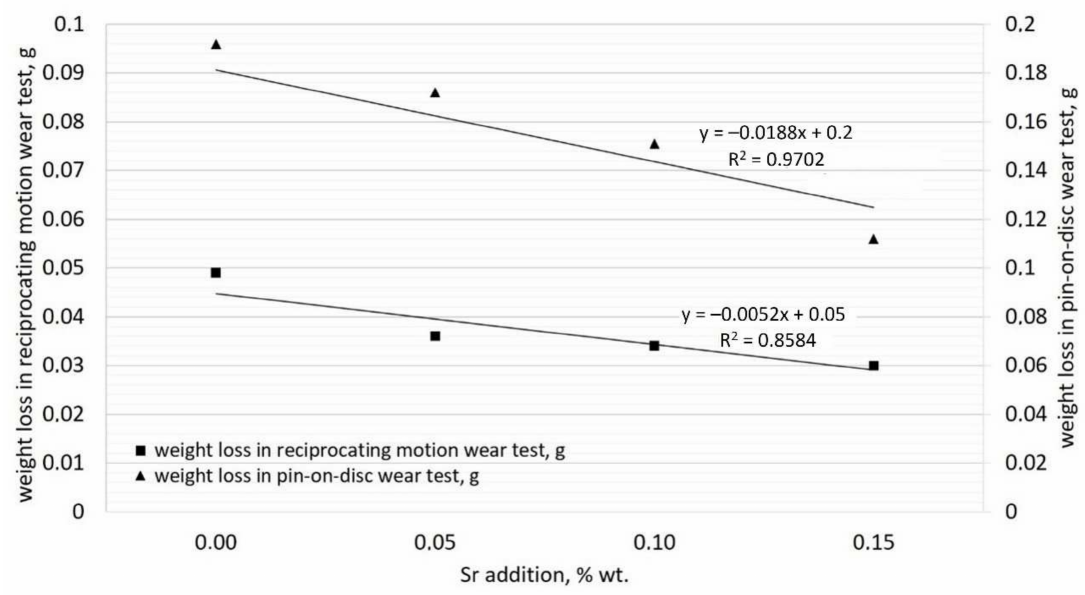
Figure 10. Influence of Sr addition on wear resistance of examined